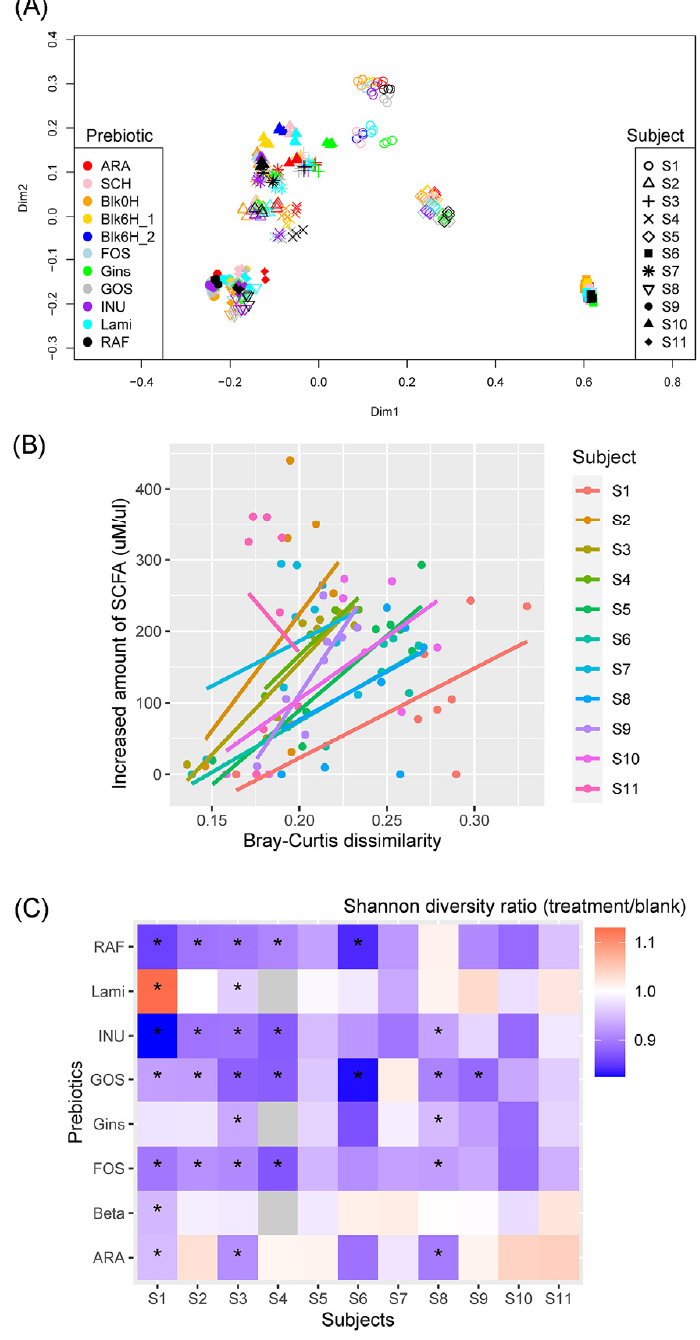
Figure 1. ( A ) Two-dimensional plot of the principle coordinate analysis (PCoA) based on Bray–Curtis distances of bacterial communities between samples. ( B ) A scatter plot with linear regression lines showing the relationship between community shifts and the increase in the SCFA amount. Bray–Curtis distances between treatment samples and blanks in each subject were calculated and plotted together with the increased amount of SCFAs. ( C ) A heatmap showing the ratio of Shannon diversity between treatment samples and corresponding blank samples. Asterisk (*) denotes significant difference in Shannon diversity between treatment samples and corresponding blank